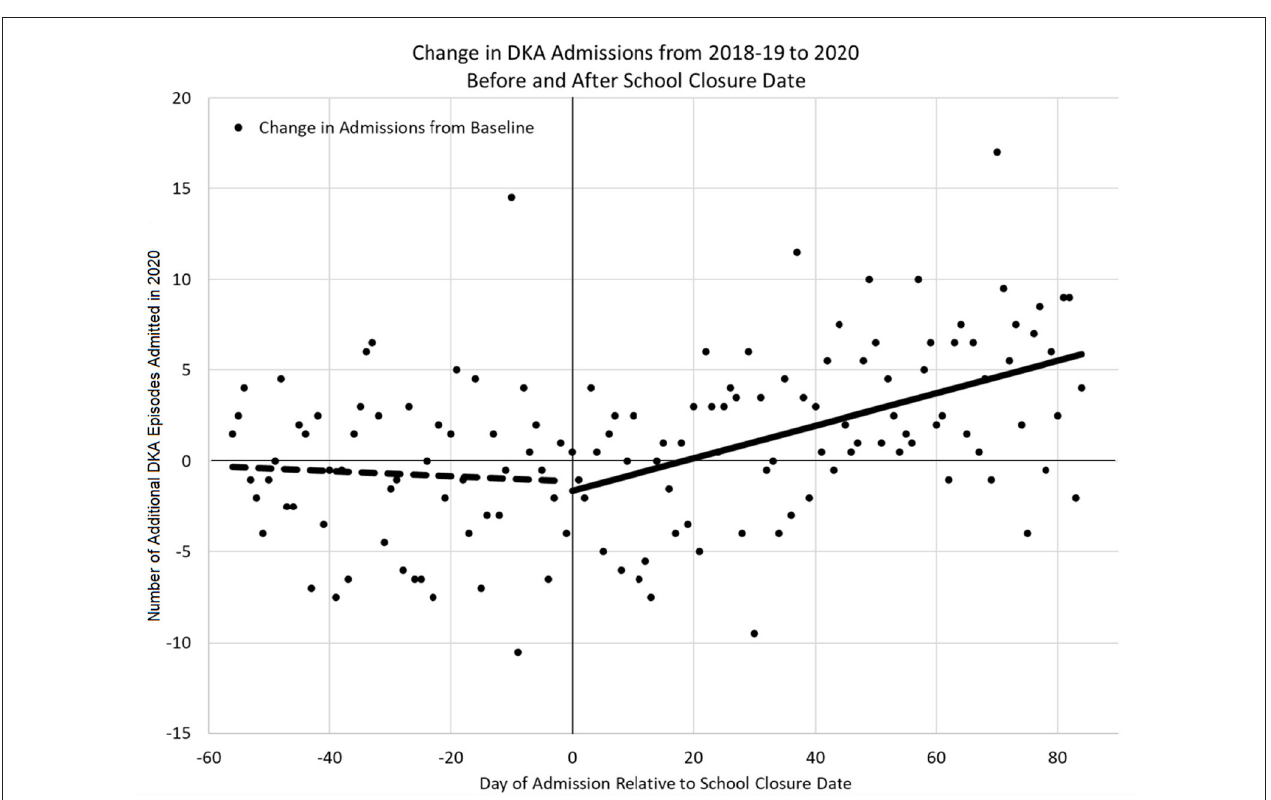
FIGURE 1 | Change in admissions due to diabetic ketoacidosis in 2020 compared to 2018–2019.